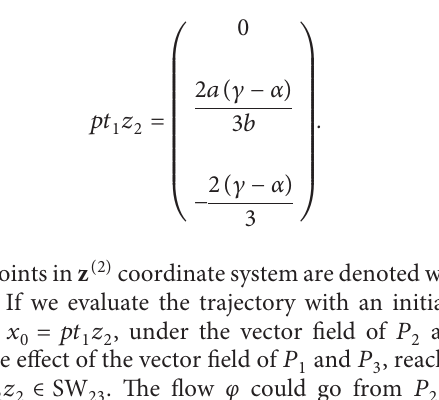
Figure 7: Illustration of the local manifold of the system. Stable manifolds are in blue, unstable manifold in red, and switching surfaces in green. The points where the vector field of P are in a continuous black line. The symmetric regions R tangent to SW 23